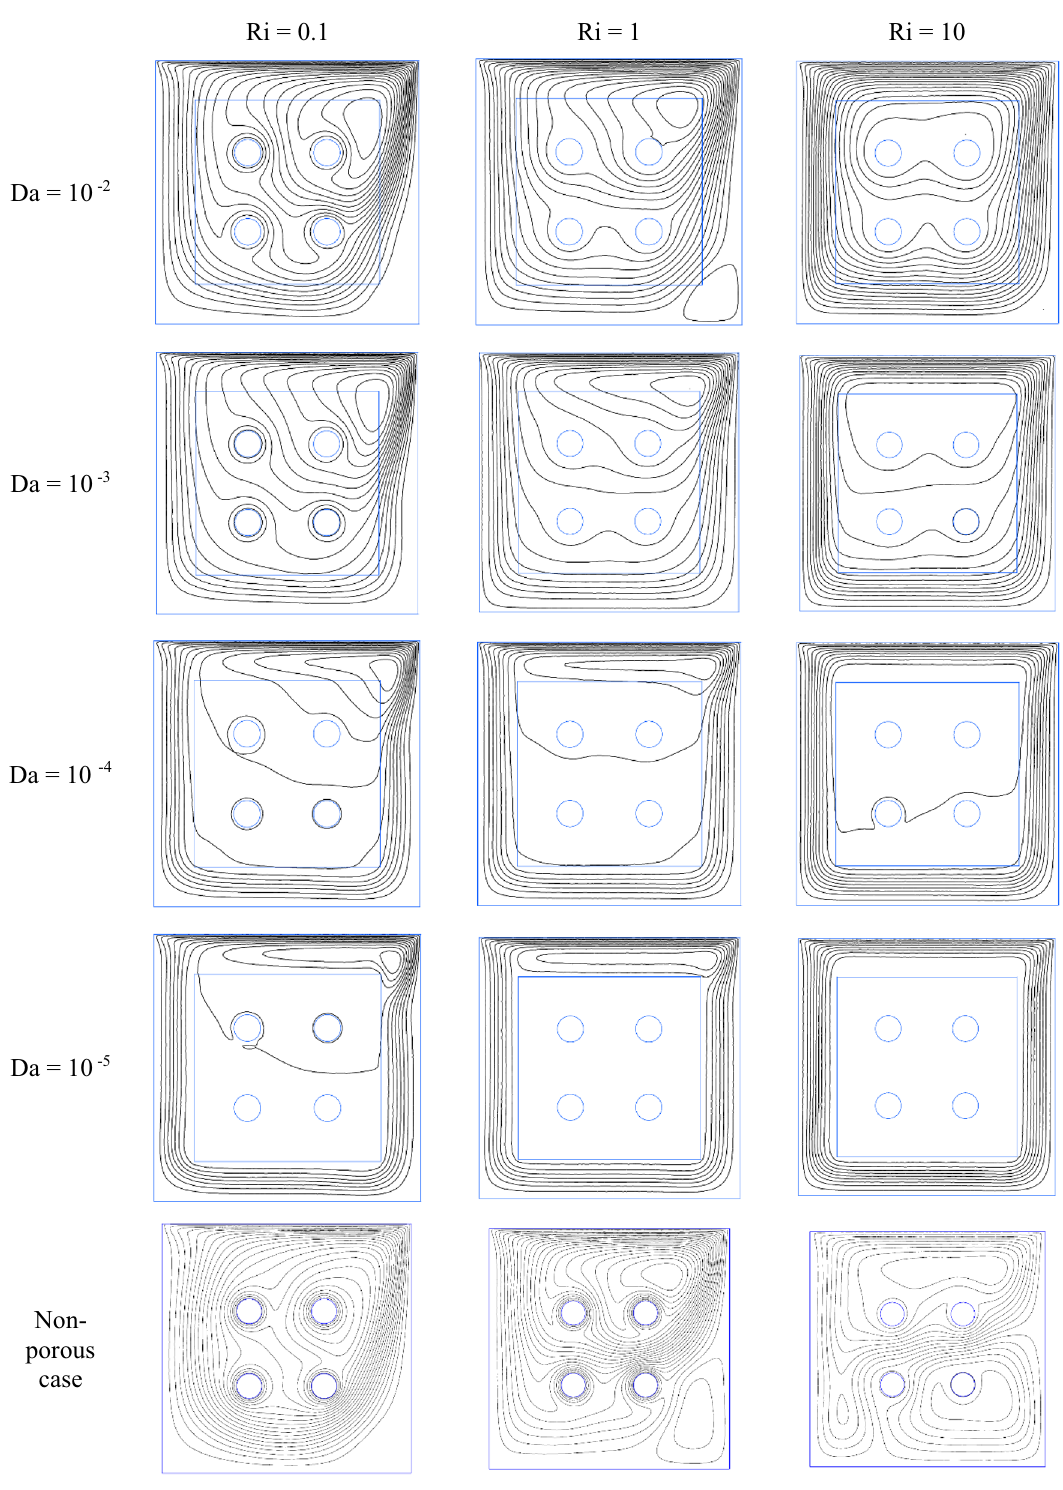
Figure 11. Dimensionless Streamline contours for φ = 0.01, τ = 0.1, ɛ =